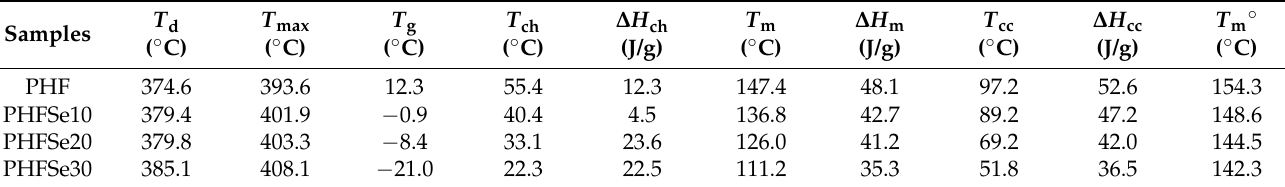
Table 2. Basic thermal behavior data of PHF and PHFSe